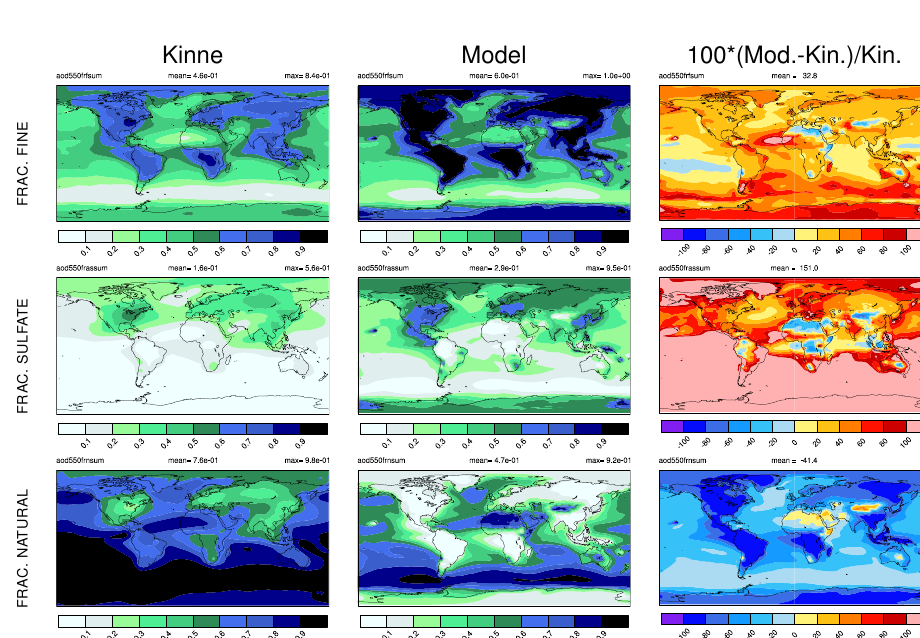
Figure 9. Same as Fig. 8, for JJA. Fig. 9. Same as Figure 8, for JJA.